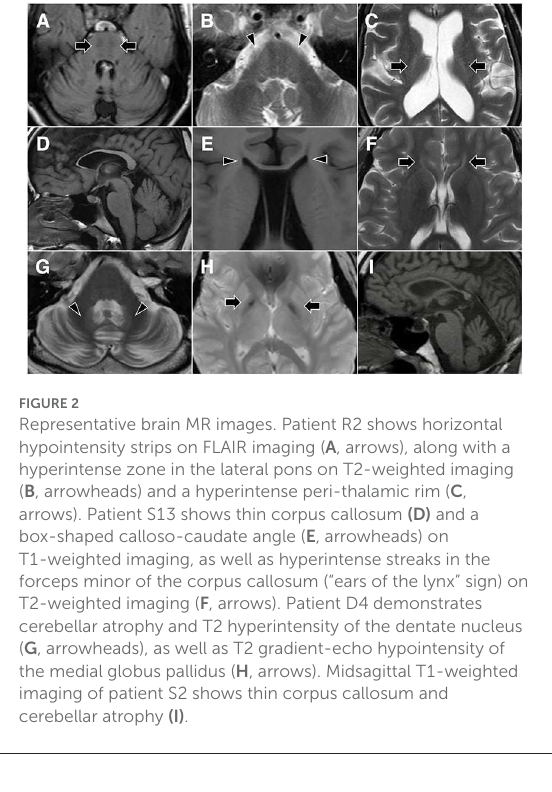
(p.Arg873His), a previously reported disease-causing